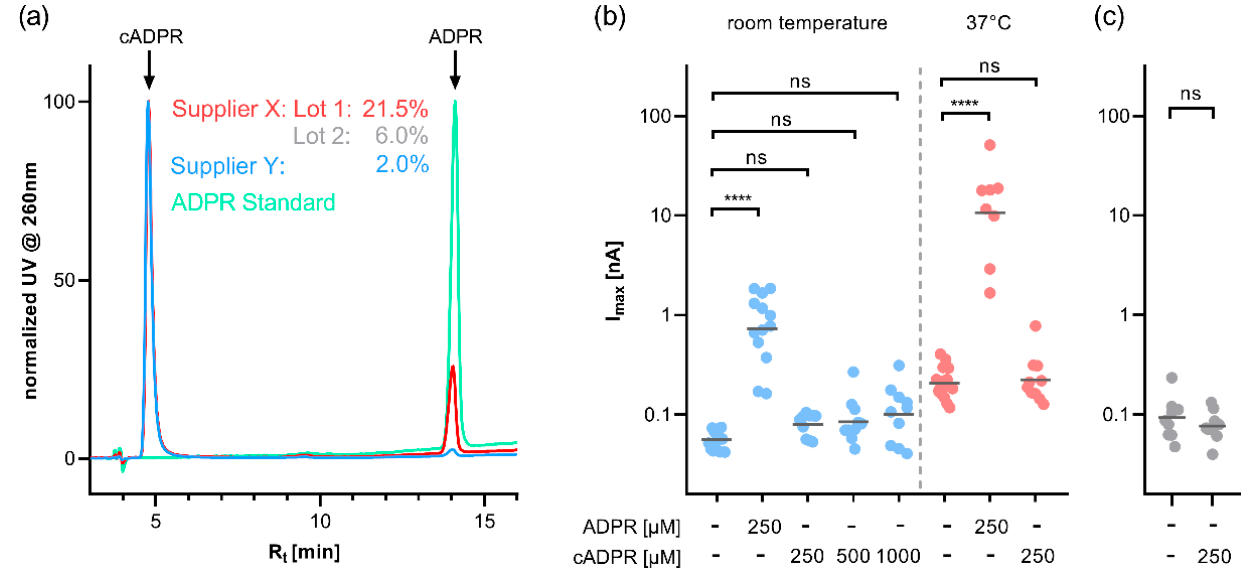
Figure 1. ( a ) HPLC analysis of cADPR from different suppliers (red, grey and blue). Due to the varying amount of cADPR in the preparations, the chromatograms have been normalised to the cADPR peak to illustrate the different fractions of ADPR in the preparations. The ADPR standard (green) is shown for comparison. ( b ) cADPR does not activate human TRPM2 at either room temperature or at 37 ◦ C. HEK293 cells with stable expression of human TRPM2 were infused via the patch pipette with an intracellular solution buffered to a Ca 2+ of 200 nM with EGTA and containing either 250 µ M ADPR or 250 µ M cADPR. Cells were kept at either room temperature (blue) or 37 ◦ C (red) by continuous perfusion with bath solution. The bath solution contained NMDG instead of Na + . (See Supplementary Material Figure S1 for representative time courses and a schematic representation of the voltage ramp) ( c ) cADPR does not activate human TRPM2 in a bath solution with NaCl. At room temperature, TRPM2-expressing HEK293 cells were infused with an intracellular solution that contained either no nucleotide or 250 µ M cADPR. Max currents at +15 mV from repetitive voltage ramps are shown on a log scale. Log transformed data were tested against the respective control by one-way ANOVA followed by post hoc t test with Bonferroni correction ( b ) or two-tailed Student’s t test ( c ), the mean of the log-transformed data is indicated by a horizontal bar (**** p < 0.0001, ns not